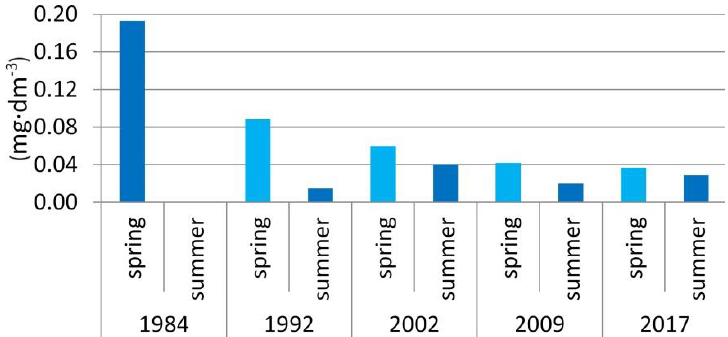
Figure 10. Changes in concentrations of total phosphorus (mg · dm − 3 ) in Lake Bor ó wno in 1984–2017